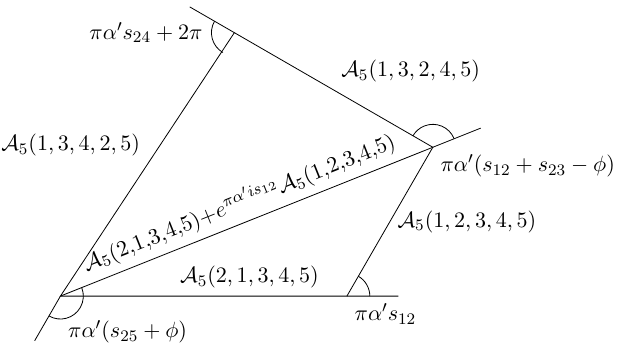
Figure 12. An triangle made from the diagonal line of the five-point gluonic Plahte diagram. forms a triangle. It turns out that the corresponding Plahte identities for the triangle coincide with the BCJ relations derived from the BCFW recursion relations of the five gluon scattering